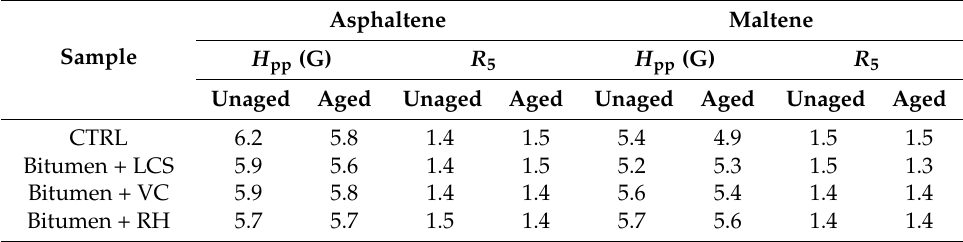
Table 3. Peak-to-peak separation of the derivative peak ( H pp ) and lineshape parameter ( R 5 ) of EPR spectra of asphaltene and maltene fractions obtained both from unaged bituminous samples and after artificial aging through RTFOT. Asphaltene Sample